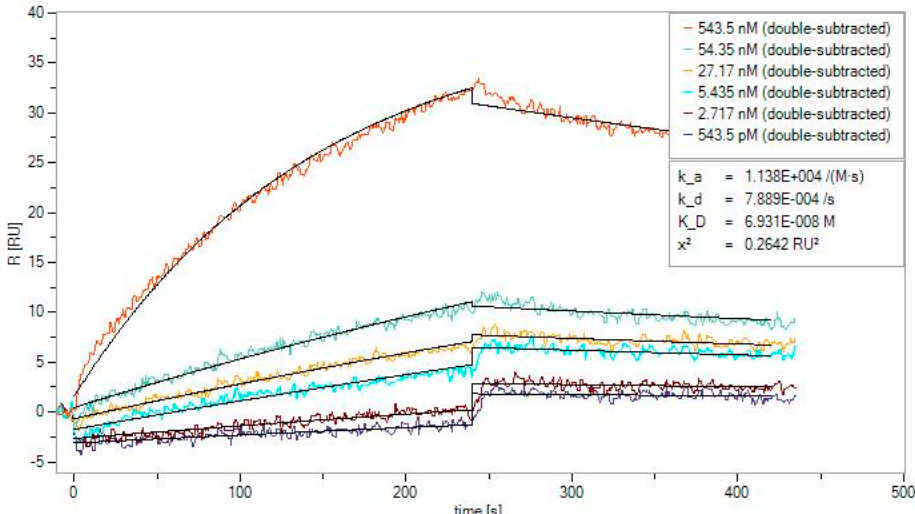
Figure 4. The affinity binding assay for BLG nanoMIPs. Signals were subtracted from the blank and the control signals (double-subtracted). Black lines represent the fitting of the Langmuir model (1:1 binding) obtained using the SPR Sensor Analyser software. The kinetic fitting parameters are reported under the bottom left inset.